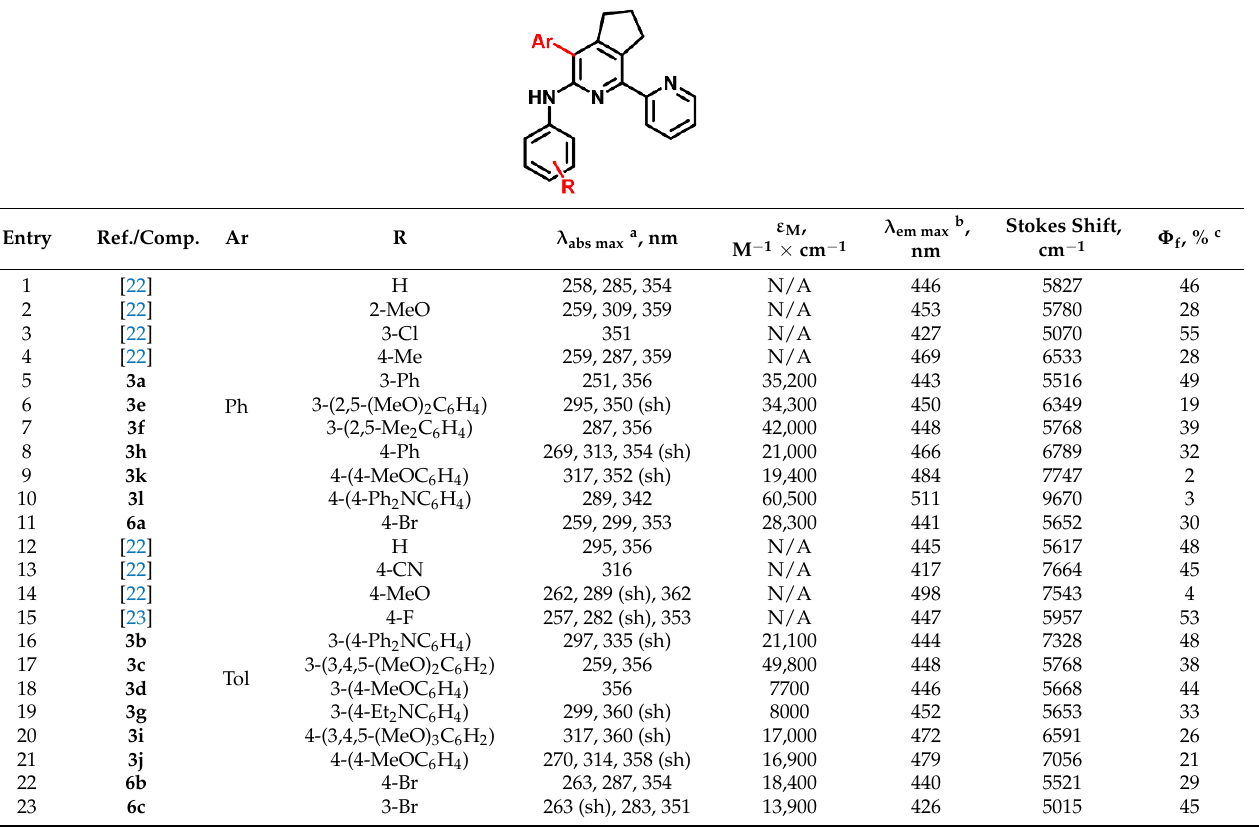
Table 1. Photophysical properties of α -arylamino-2,2 ′ -bipyridines 3a – l in THF solution